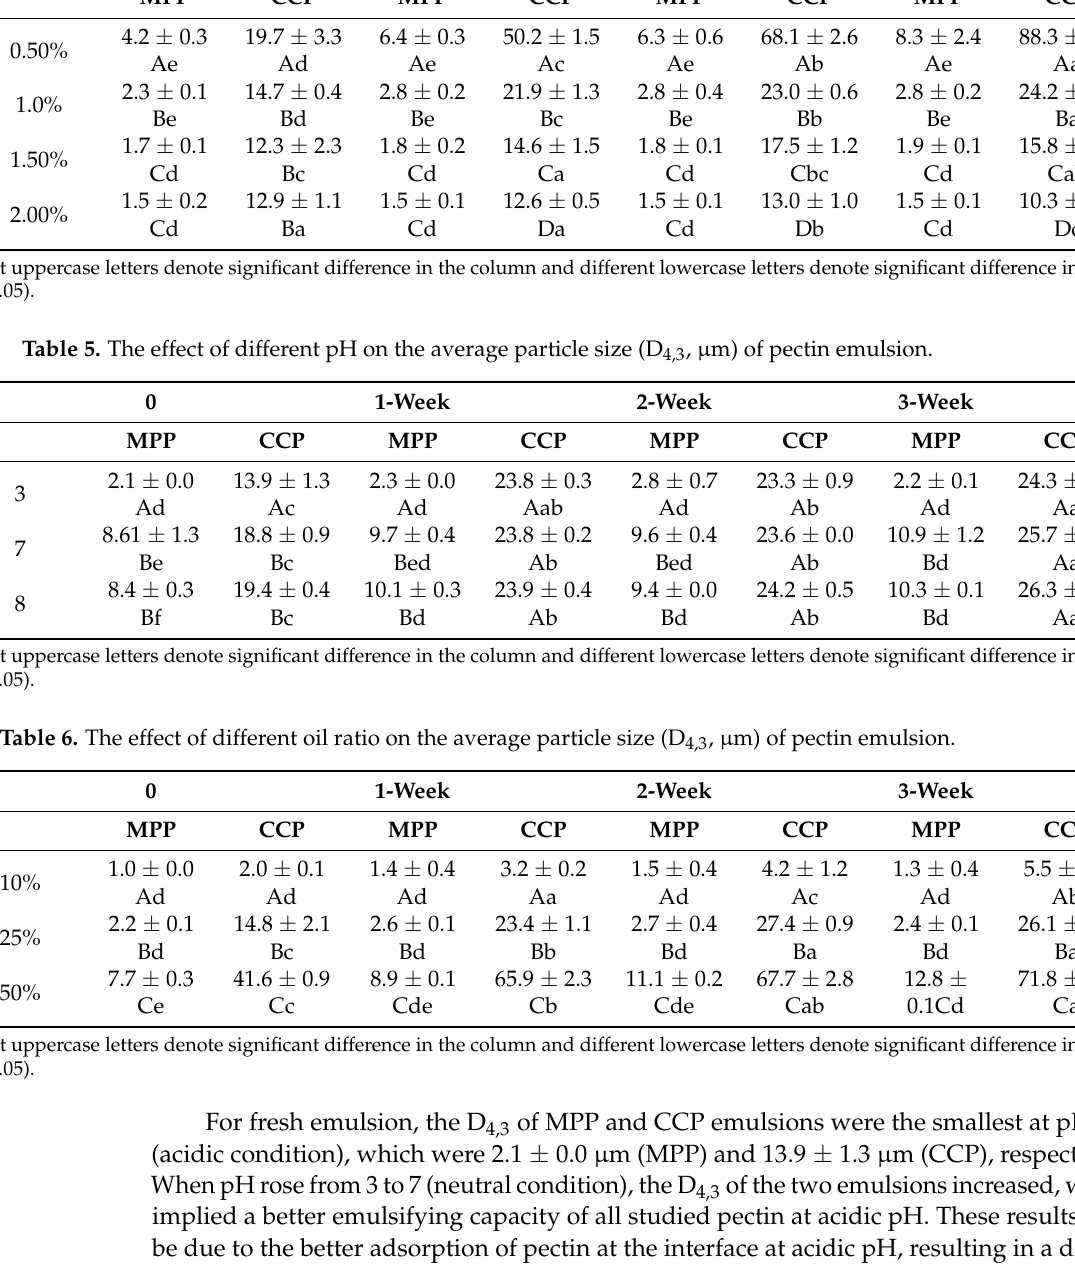
Table 4. The effect of different pectin concentration on the average particle size (D 4,3 , µ m) of pectin emulsion. 0